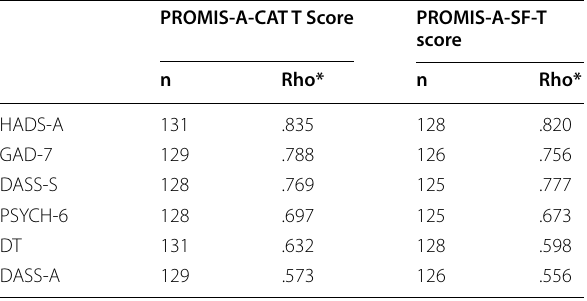
Table 4 Correlations between PROMIS anxiety measures and legacy